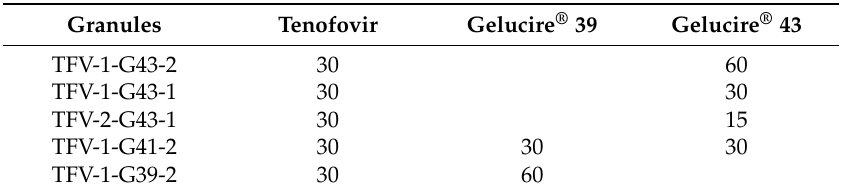
Table 1. Granule composition